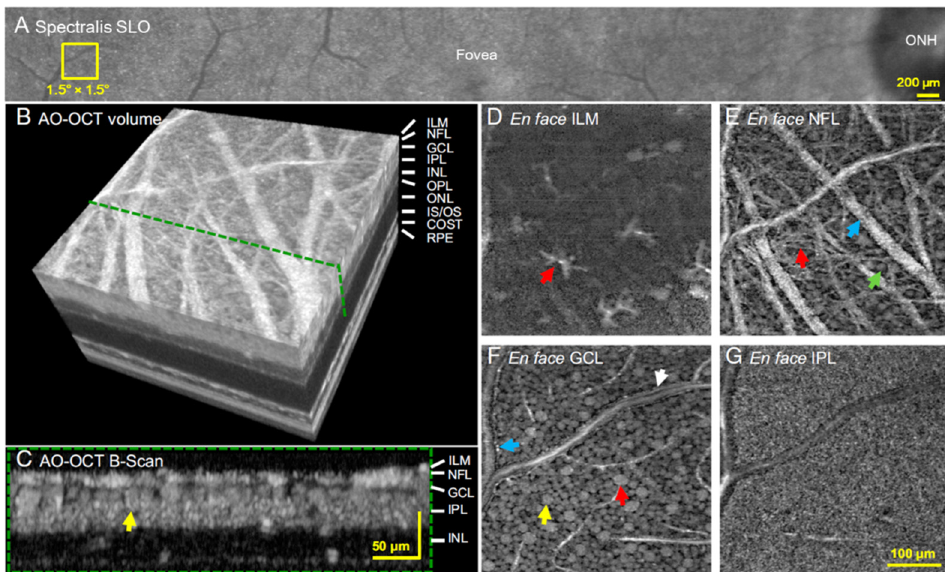
Figure 8. Cellular structures of the inner layers of the retina using AO-OCT. ( A ) Yellow square at 12–13.5° temporal to the fovea in subject S3 denoted location imaged with AO-OCT. ( B ) 3D perspective of registered and averaged AO-OCT volume with green dashed line denoting cross-section of inner retina shown in ( C ). Yellow arrow indicates the same GCL soma in ( C , F ). Images shown in ( D – G ) were extracted at depths of 0, 13, 22, and 46 μ m below ILM. Scale bar in ( G ) also applies to ( D – F ). ( D ) Surface of ILM. ( E ) A complex web of nerve fiber bundles of varying size dispersed across the NFL. ( F ) A mosaic of GCL somas of varying sizes tiled the layer. ( G ) The dense synaptic connections between axons of bipolar cells and dendrites of ganglion and amacrine cells presented as a uniform mesh of high spatial frequency irregularities in the IPL. ILM, internal limiting membrane; NFL, nerve fiber layer; GCL, ganglion cell layer; IPL, inner plexiform layer; INL, inner nuclear layer; COST, cone outer segment tip; IS/OS, inner segment/outer segment junction; ONL, outer nuclear layer; OPL, outer plexiform layer (Reprinted with permission from Ref. [134]. Copyright 2017, Liu et al.).